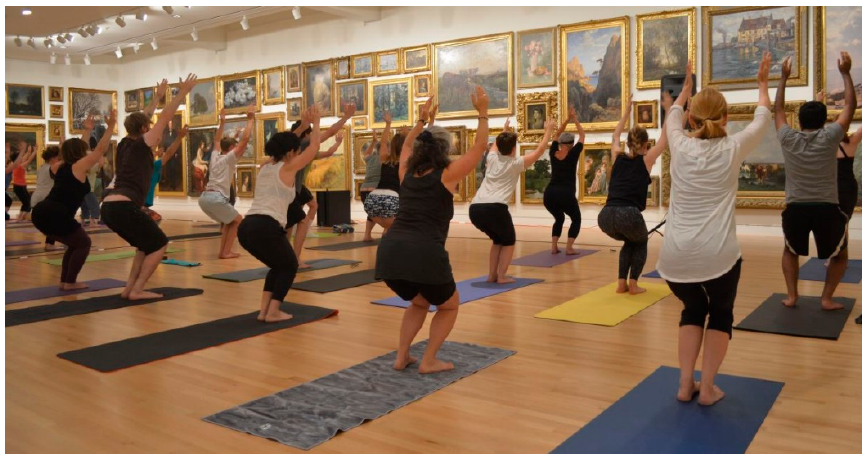
Figure 1. Seattle Art Museum “Where Art Meets Life” Yoga Program. Source: Seattle Art Museum.